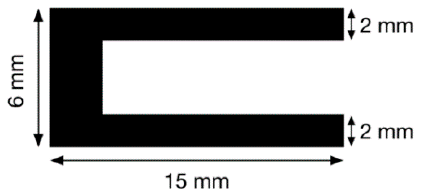
Figure 2. Dimensions of the U-shaped CB/TPE conducitve polymer sensor.